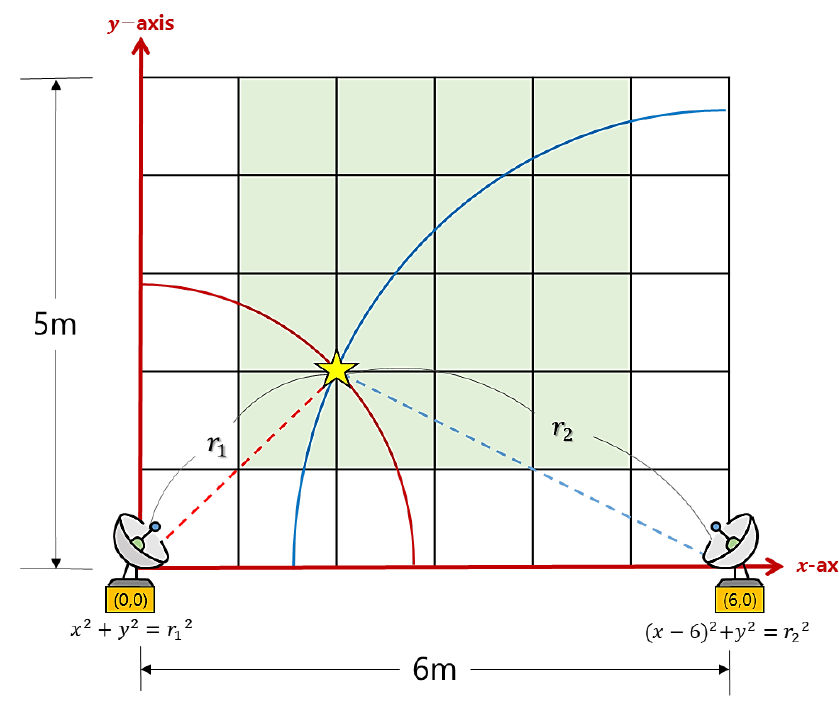
Figure 5. Schematic of 2D localization scheme based on a multilateration method.